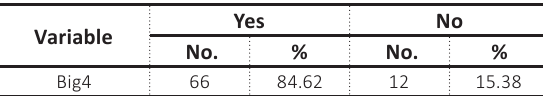
Table 4. Descriptive statistics for dummy control variables